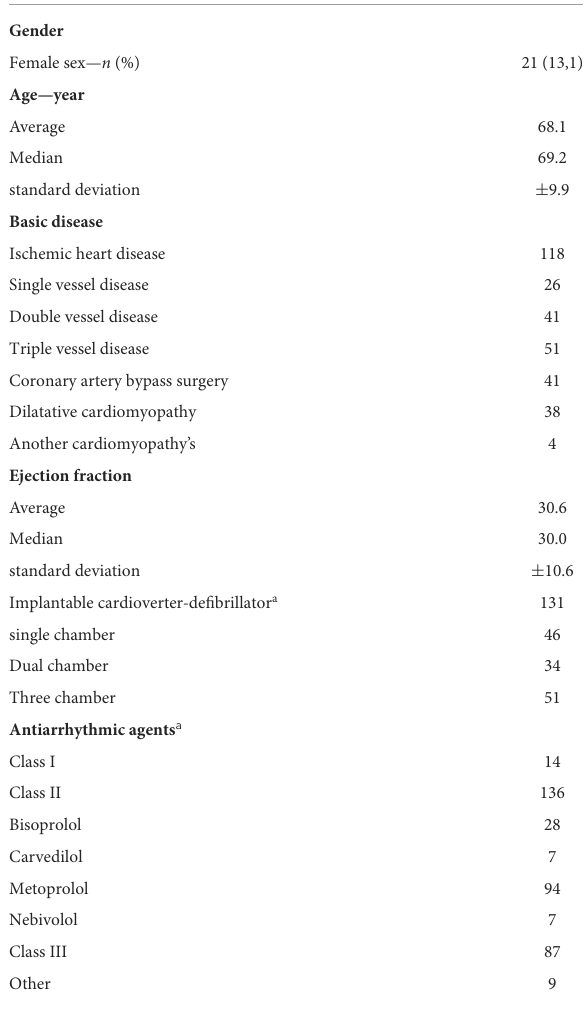
TABLE 1 Characteristics of the patients at